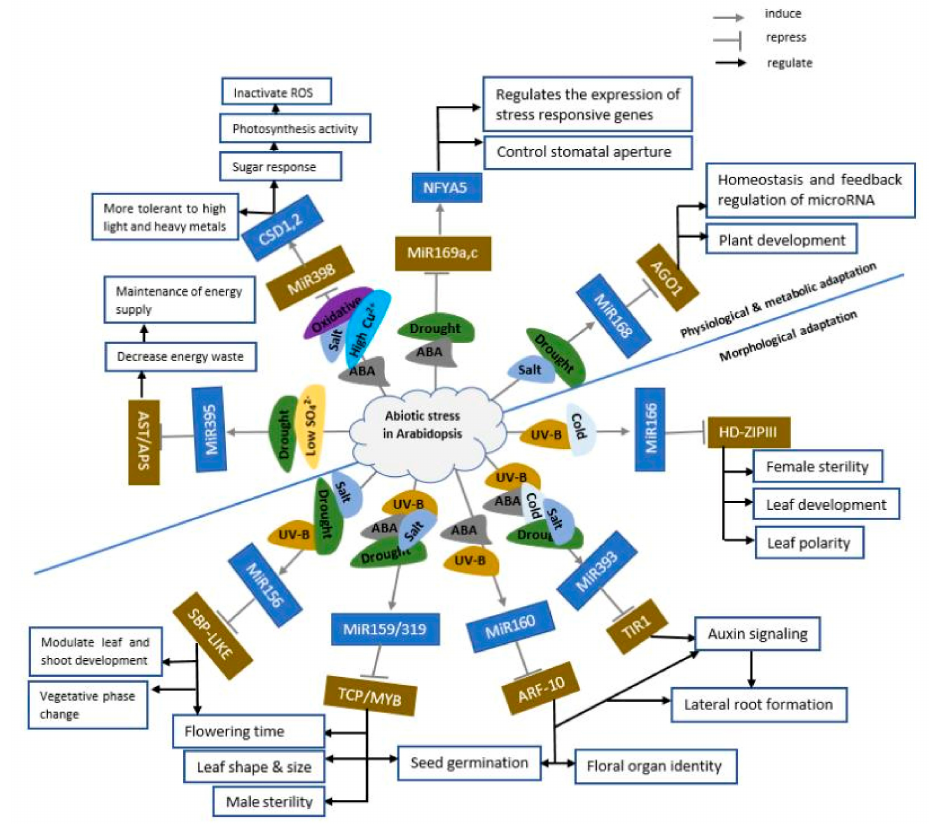
Figure 7. Regulatory network of miRNAs in Arabidopsis under abiotic stress. The proposed network describes the molecular mechanisms underlying the response of Arabidopsis plants to various abiotic stresses. The network is solely based on alterations in miRNA expression patterns and subsequent target transcripts in stressed